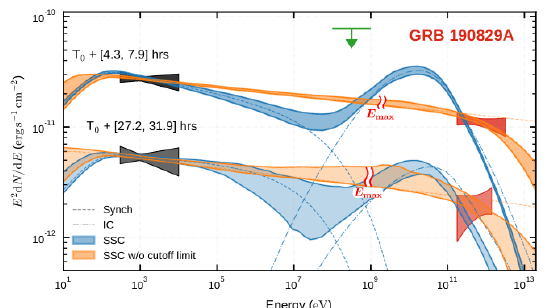
Figure 11. Multi-wavelength models of the first two nights of GRB 190829A H.E.S.S. The black region represents the spectrum and uncertainty of the Swift -XRT observations, while the red region is the H.E.S.S. intrinsic spectrum and its uncertainty. The green arrow is the upper limit set by observation during the first night by Fermi -LAT. The used model is a standard SSC model with 68% confidence intervals determined from the posterior probability distribution of the model’s parameter fitting for the synchrotron component (orange) and the SSC one (blue). No synchrotron cut-off energy (burn-off limit) is considered. Reprinted with permission from Ref.